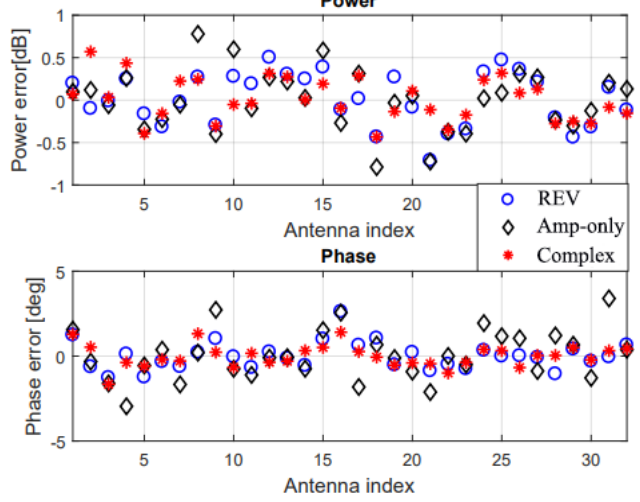
Figure 9. Array calibration error based on three methods with R = 1